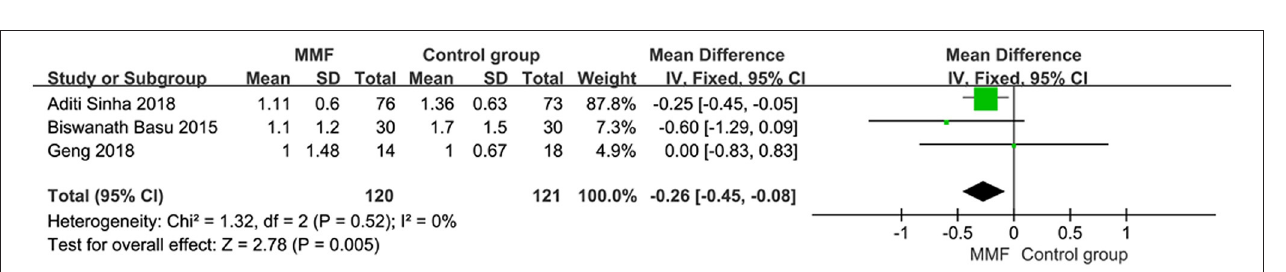
FIGURE 3 | Forest plot showing ratio difference (RD) of the 1-year relapse-free survival rate between the groups.